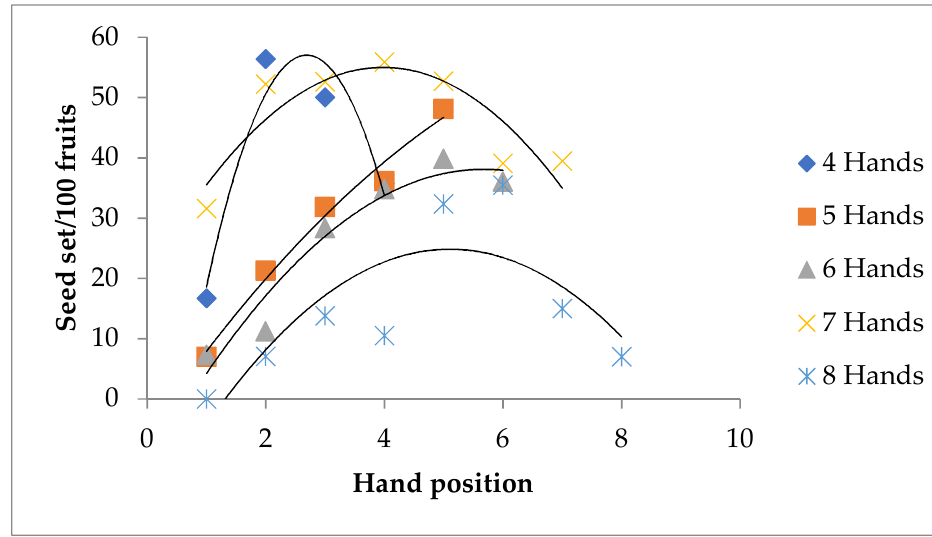
Figure 3. Seed set per 100 fruit per hand in different sized bunches of “Mshale”.